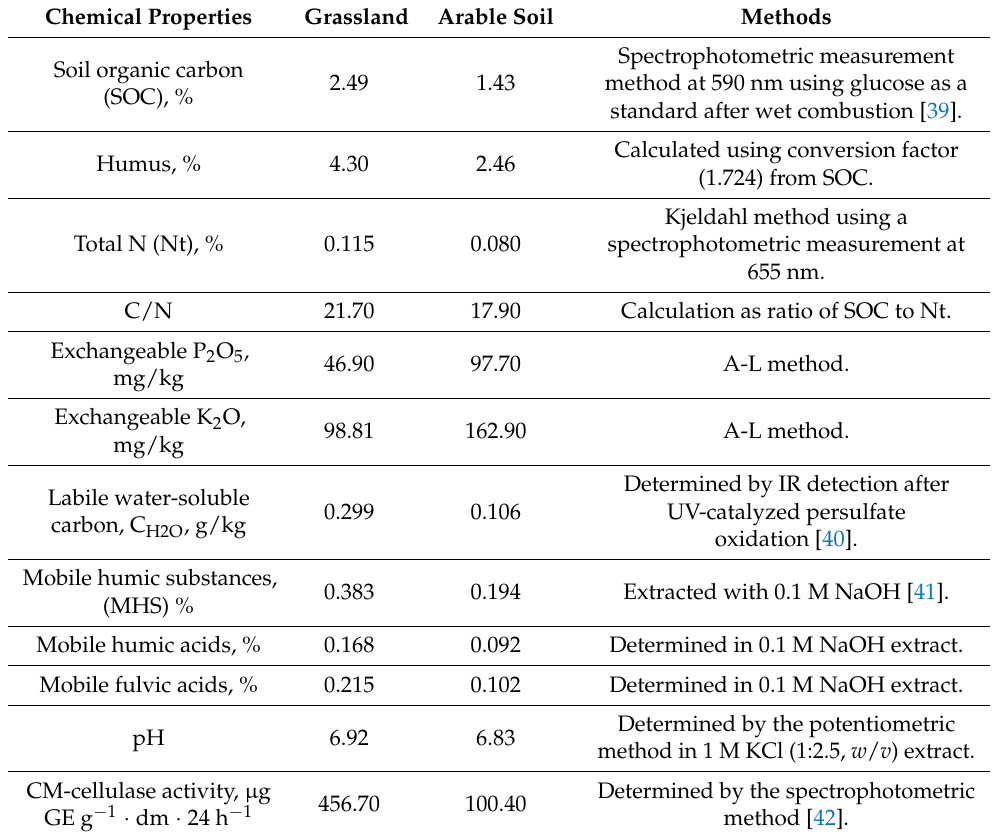
Table 1. Chemical properties of original soil samples. Chemical